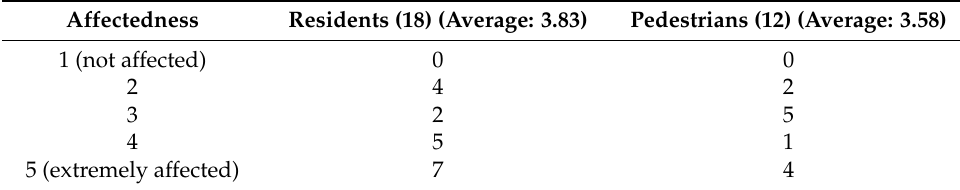
Table 1. Affectedness of municipality (average of all answers 3.73).